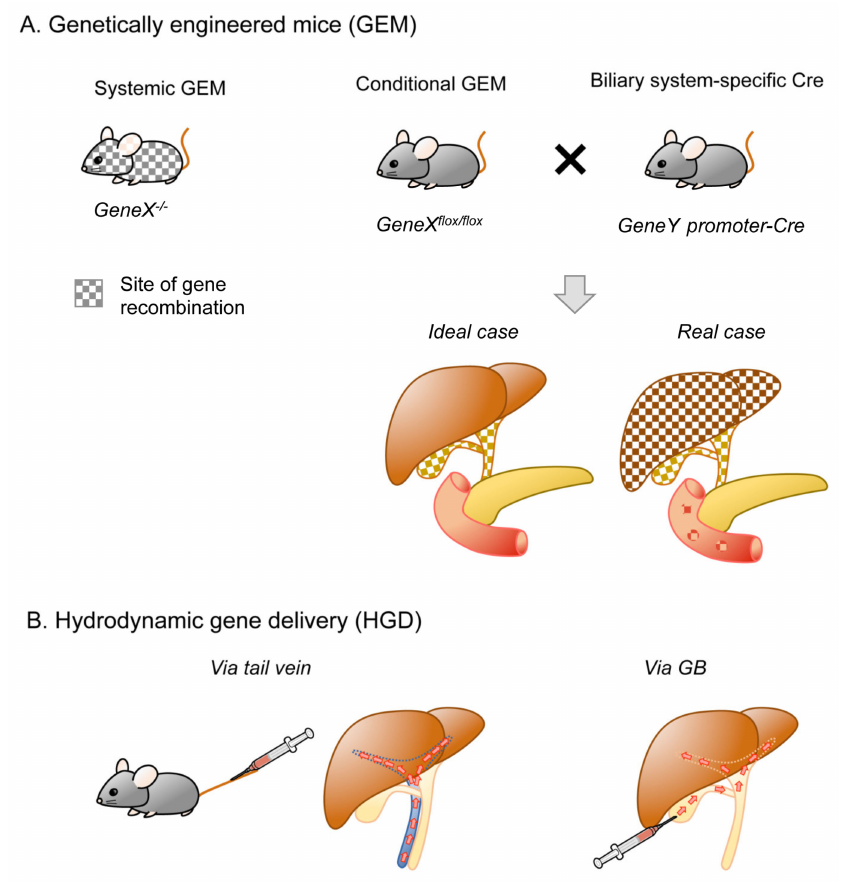
Figure 3. In vivo genetic engineering. ( A ). Genetically engineered mice (GEM). By crossing condi- tional GEM for the “gene X” and “gene Y”-Cre mice, which allow biliary system-specific recombina- tion, resultant mice are supposed to be genetically engineered only in the biliary system (left). Note that, in reality, Cre expression could be broader (right). ( B ). Hydrodynamic gene delivery (HGD). Tail vein injection is the major means of gene delivery, while injection via GB is also